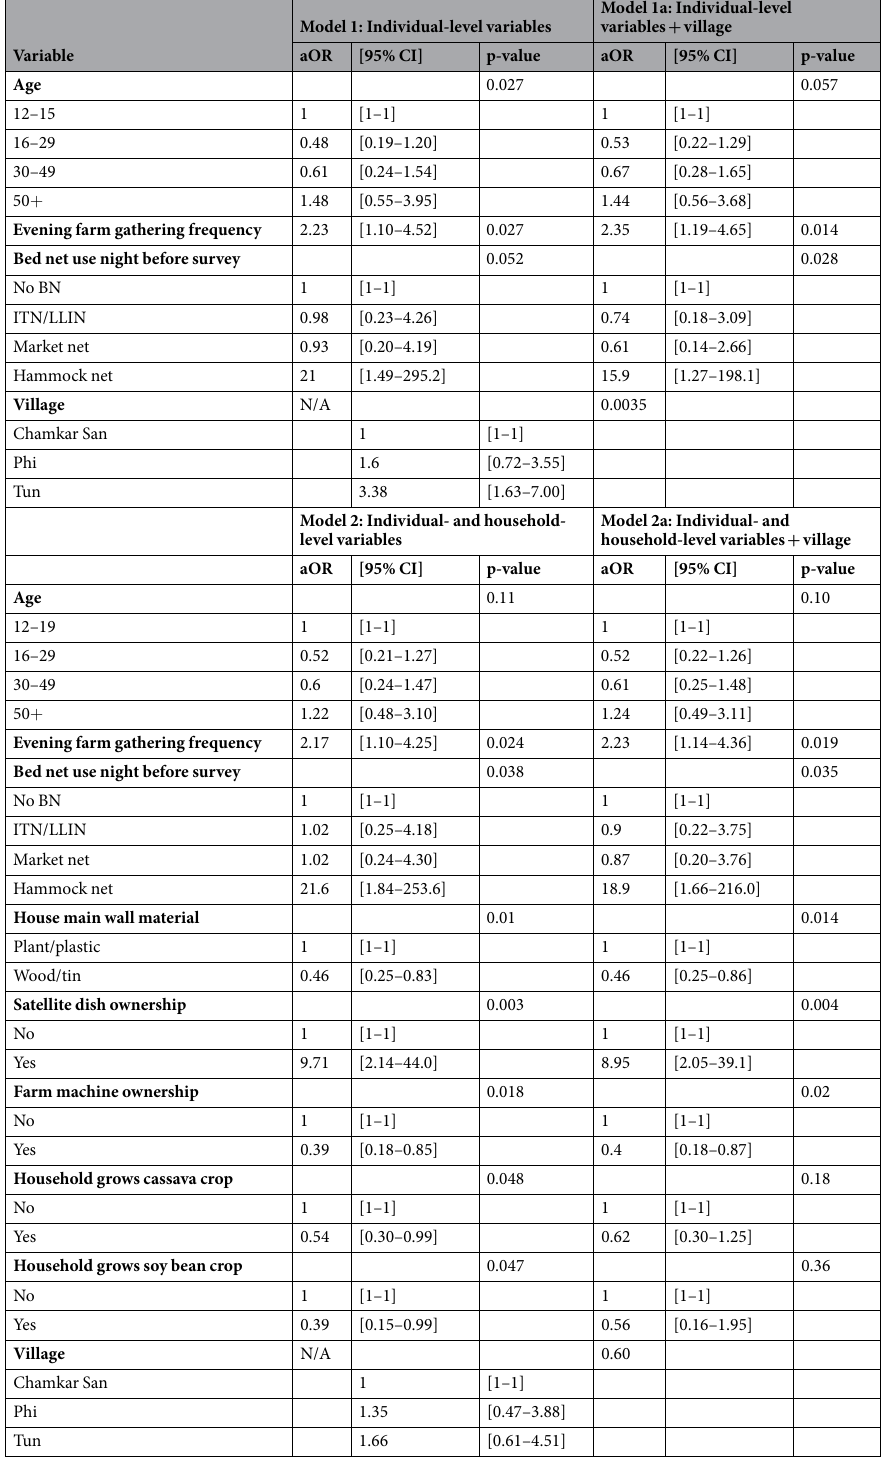
Table 6. Individual and household-level risk factors for Plasmodium infection (adolescents and